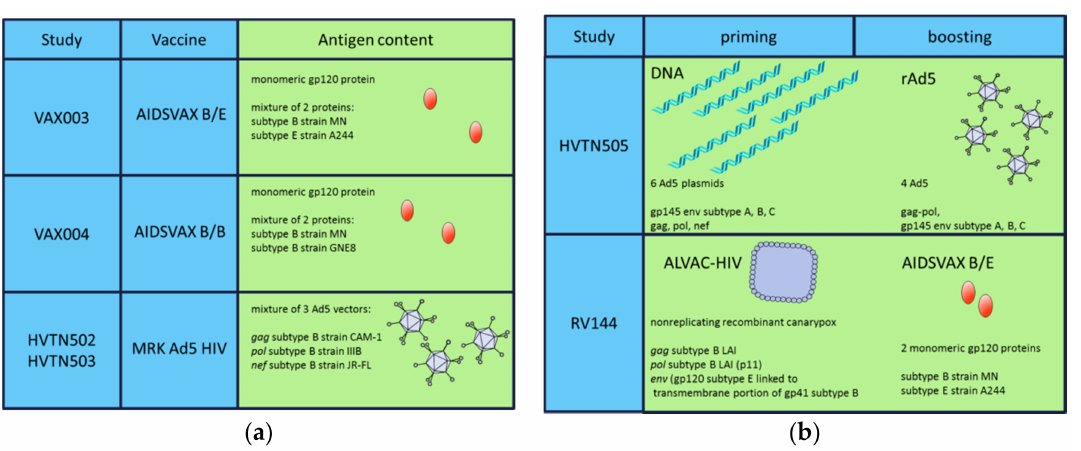
Figure 2. Vaccine regimens tested in HIV-1 clinical trials. ( a ) Antigen compositions; ( b ) Priming/ boosting